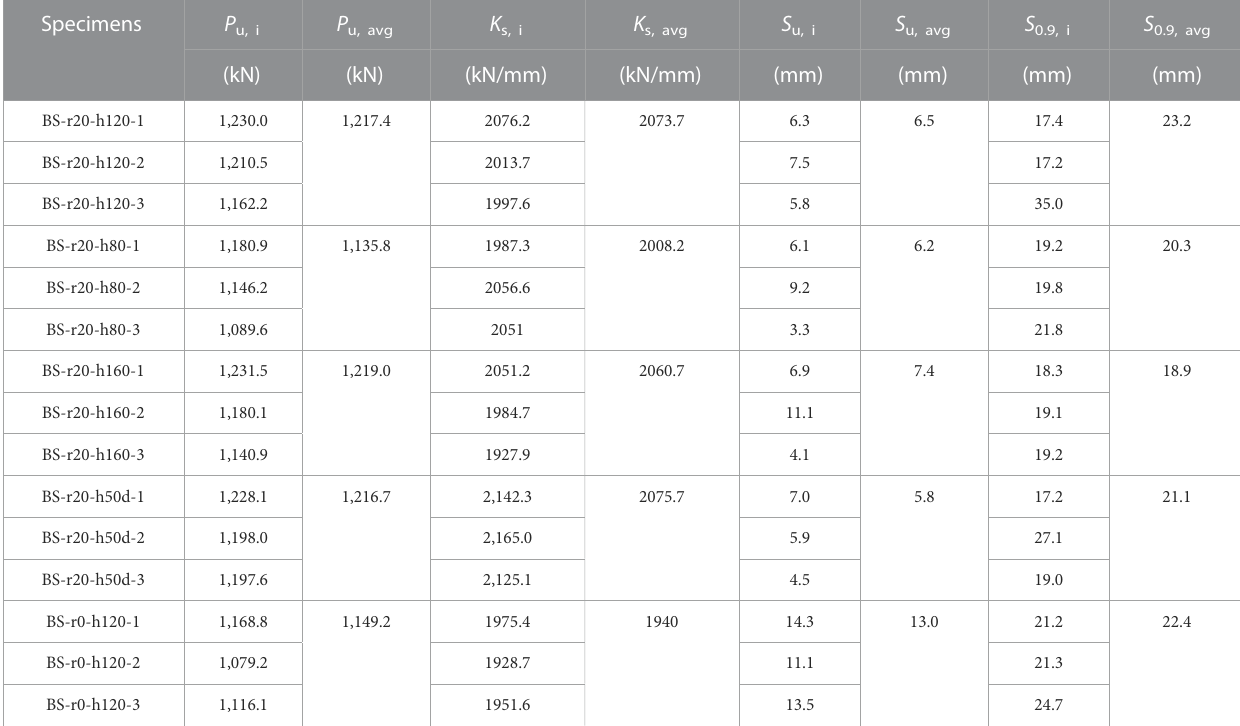
TABLE 2 Experiments